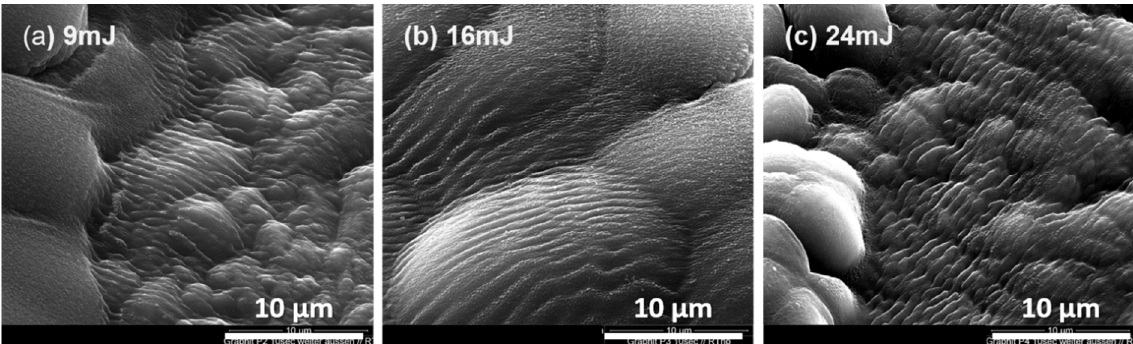
Figure 5. Zone 2. SEM images of graphite targets ablated with different laser energies. Irradiation time: 10 s/150 pulses.